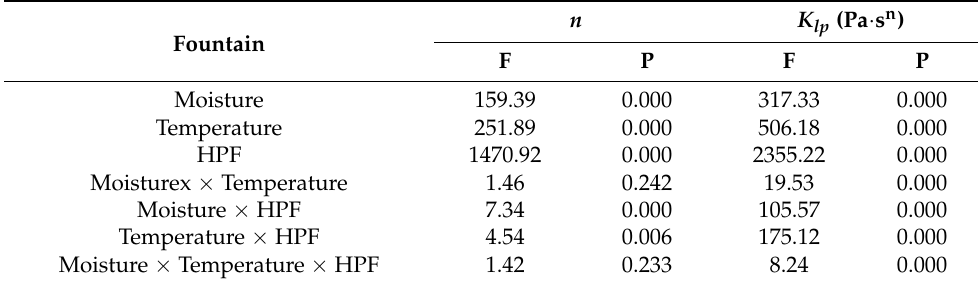
Table 6. Analysis of variance model of Power